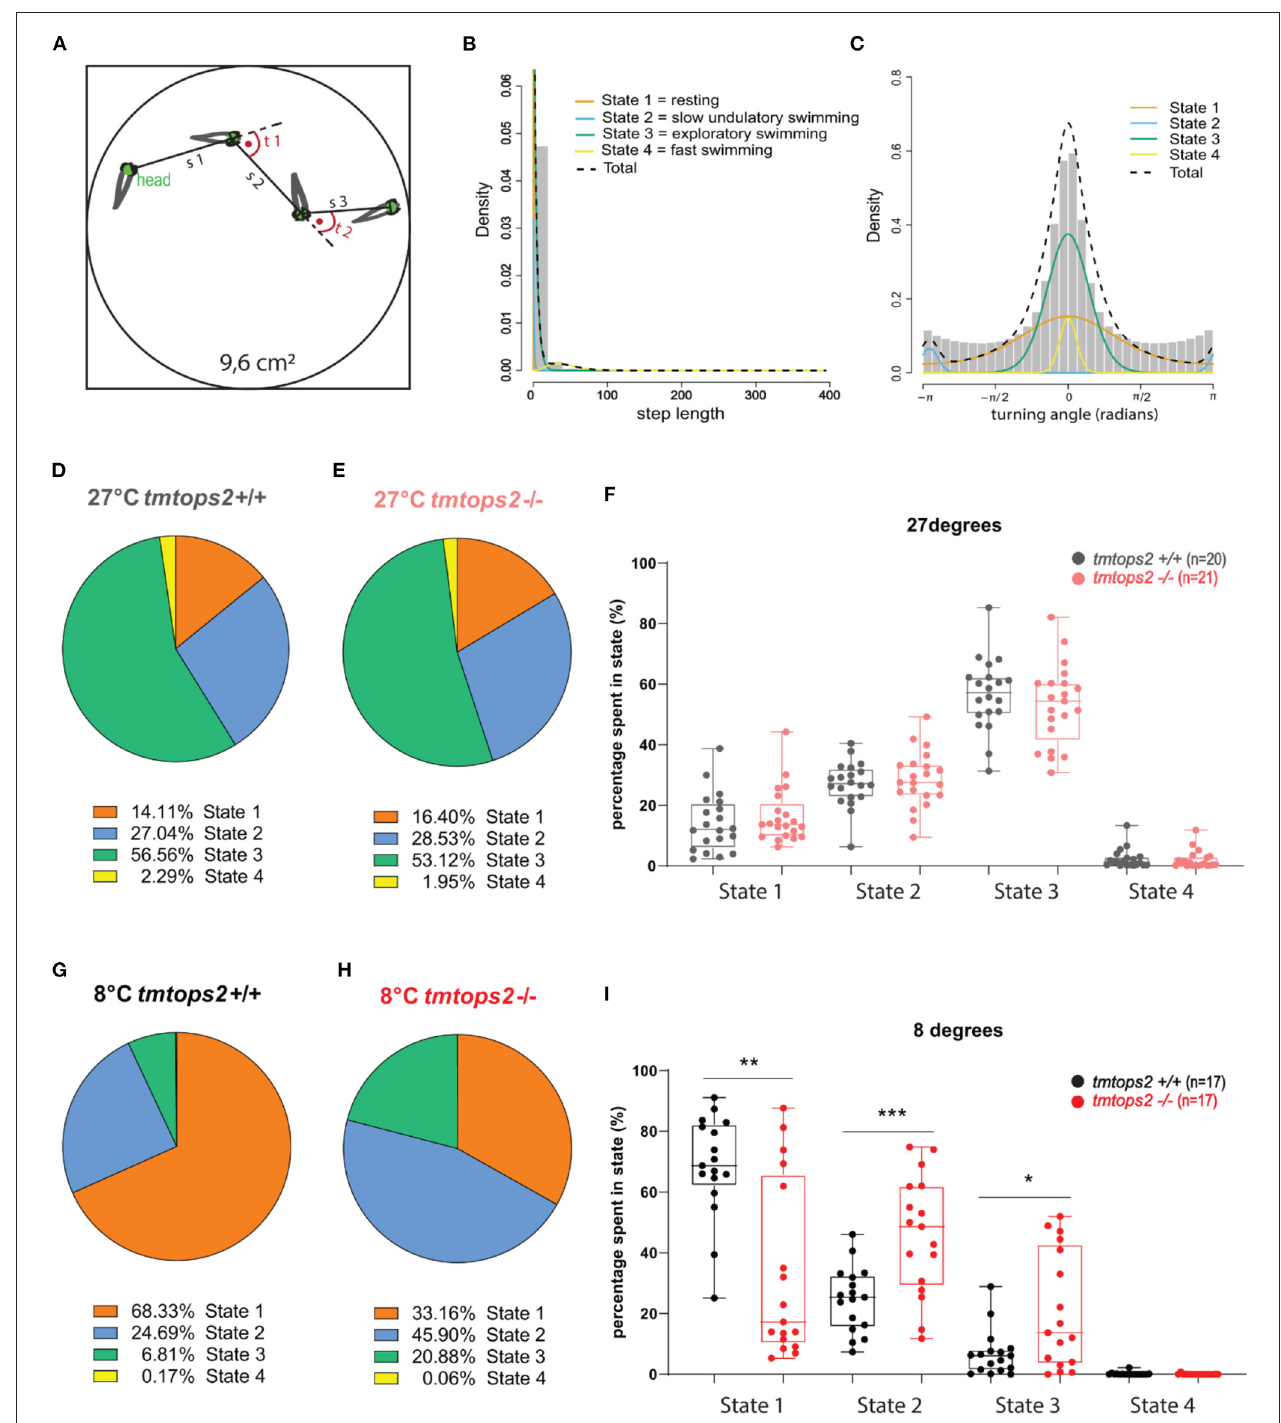
FIGURE 3 | The combination of motion tracking and the Hidden Markov principle uncovers four different behavioral states. (A) Schematic representation of the Hidden Markov principle applied to our wells. s, step length; t, turning angle. (B) Histogram plotting step lengths and (C) Turning angles, overlaid with the individual curves representing distinct state distributions: orange, state 1/resting; blue, state2/slow undulatory movement; green, state 3/exploratory swimming; yellow, state 4/fast swimming. (D,E,G,H) Pie charts showing the ratios of each state in percentages. (F,I) State percentages from each biological replicate used, plotted individually per state and genotype. a.u., arbitrary units. *** p ≤ 0.001, ** p ≤ 0.01, * p ≤ 0.05. n = 20/17 (wt 27/8 ◦ C) and n = 21/17 ( tmtops2 mut 27/8 ◦ C). For histograms of step length and turning angle of each state, as shown in Supplementary Figure 4 .